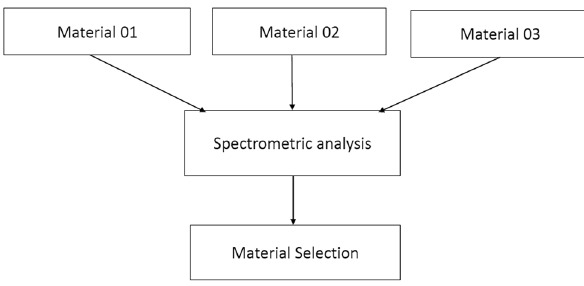
Figure 7: Flow chart of the covering material selection methodology.